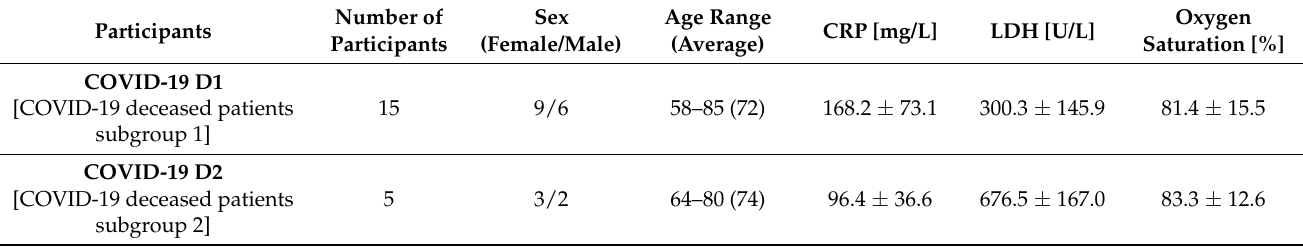
Table 2. Characteristics of two subgroups of deceased COVID-19 patients [COVID-19 D1] and [COVID-19 D2]